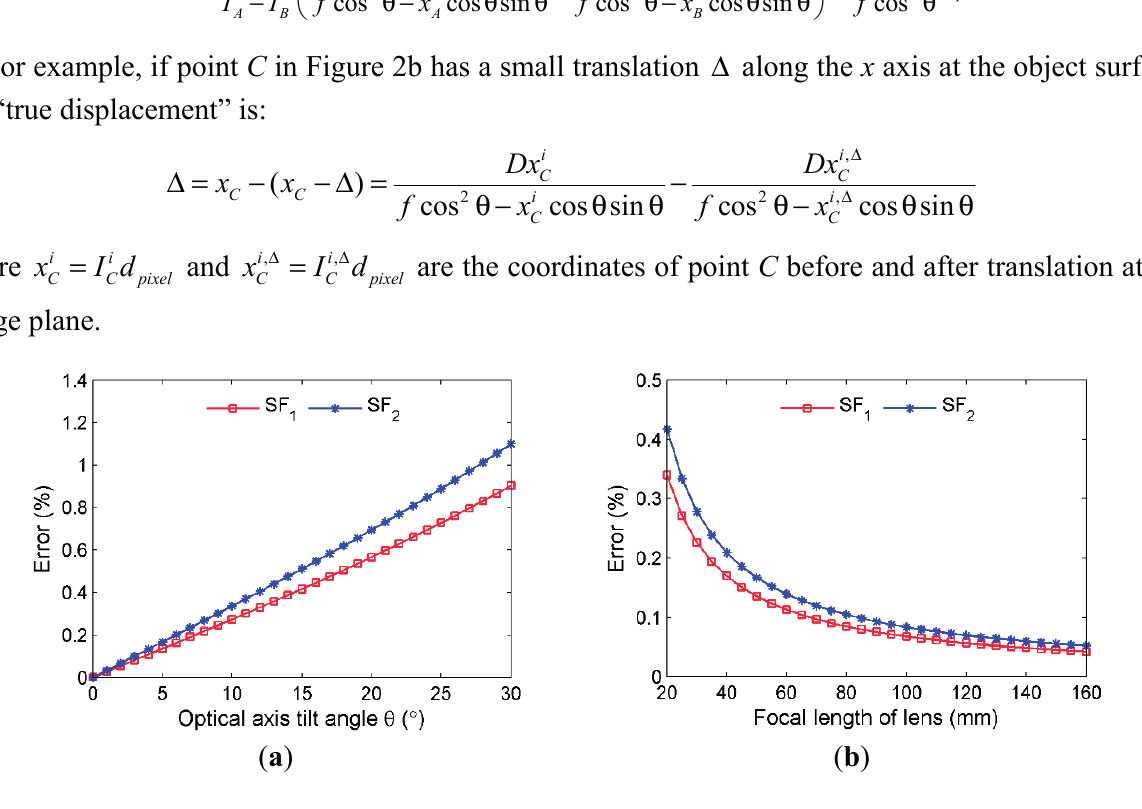
Figure 3. Error resulting from camera non-perpendicularity: ( a ) Effect of optical axis tilt angle ( f = 50 mm); ( b ) Effect of focal length of lens ( θ = 3°). SF in Equation (2) and SF in Equation (4), the “measured From the scaling factors 1 2